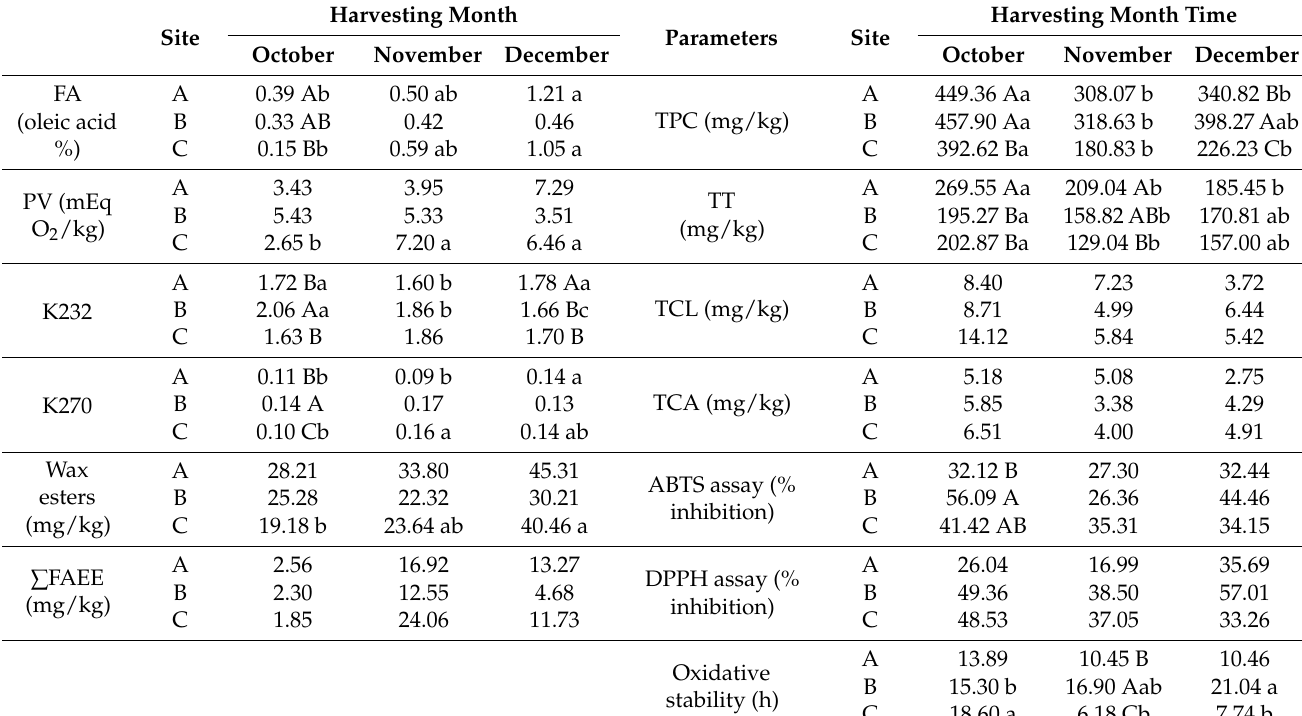
Table 1. Qualitative traits of olive oil extracted from drupes produced from trees grown in three sites (A, B, and